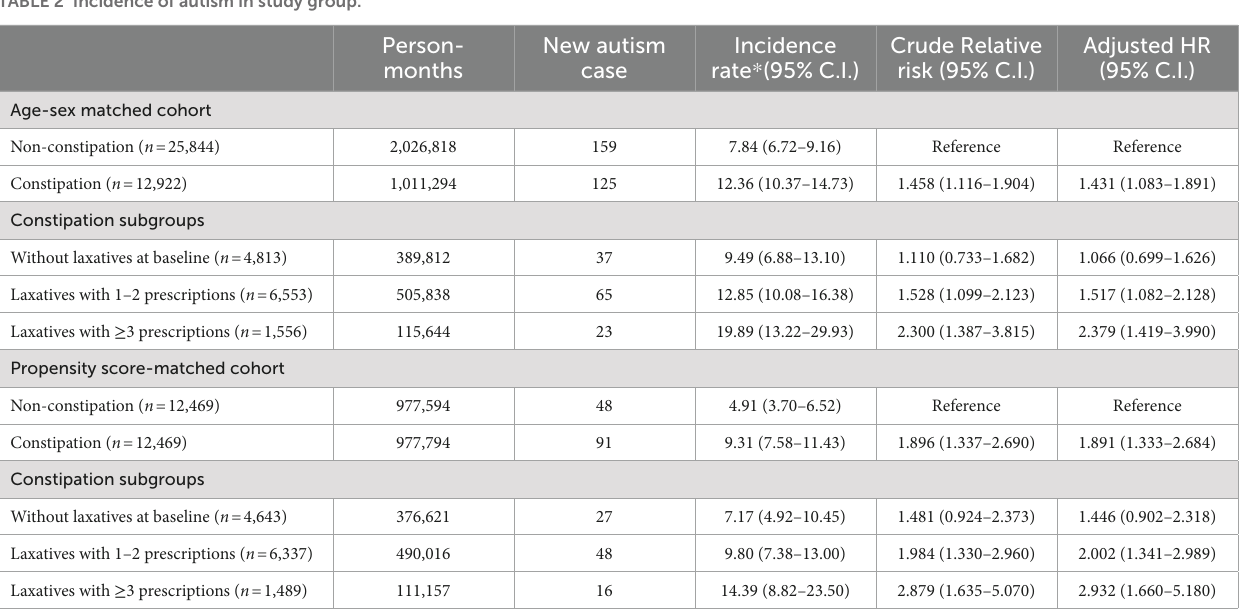
TABLE 2 Incidence of autism in study